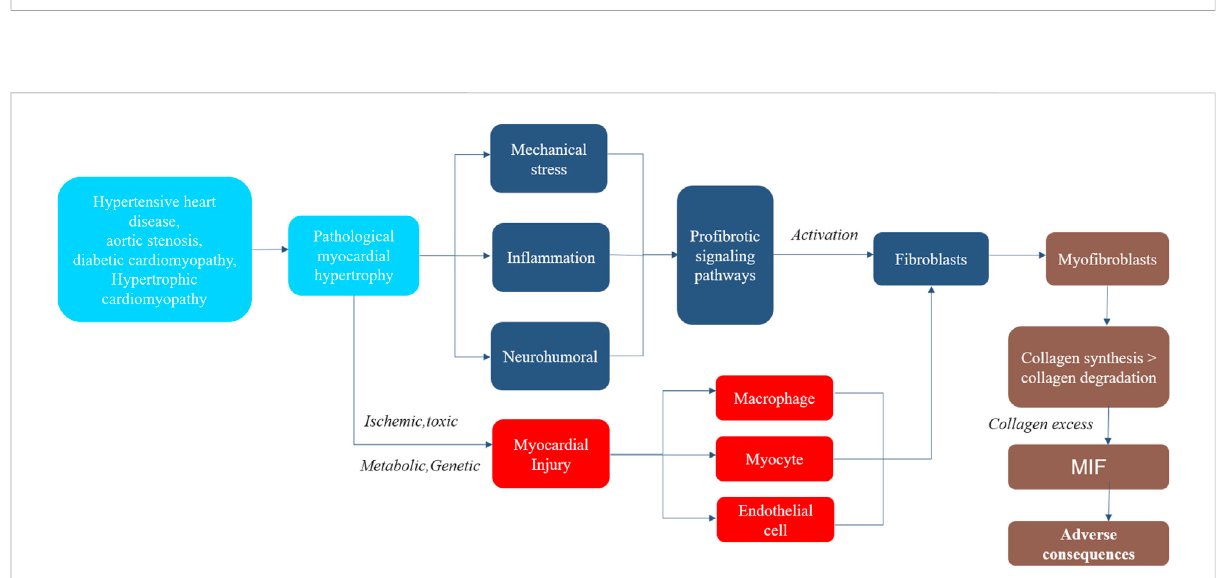
FIGURE 2 The Process of Myocardial Interstitial Fibrosis in pathological myocardial hypertrophy. Steps in the process of myocardial interstitial fi brosis, including major mechanisms and consequences. MIF, myocardial interstitial fi brosis.